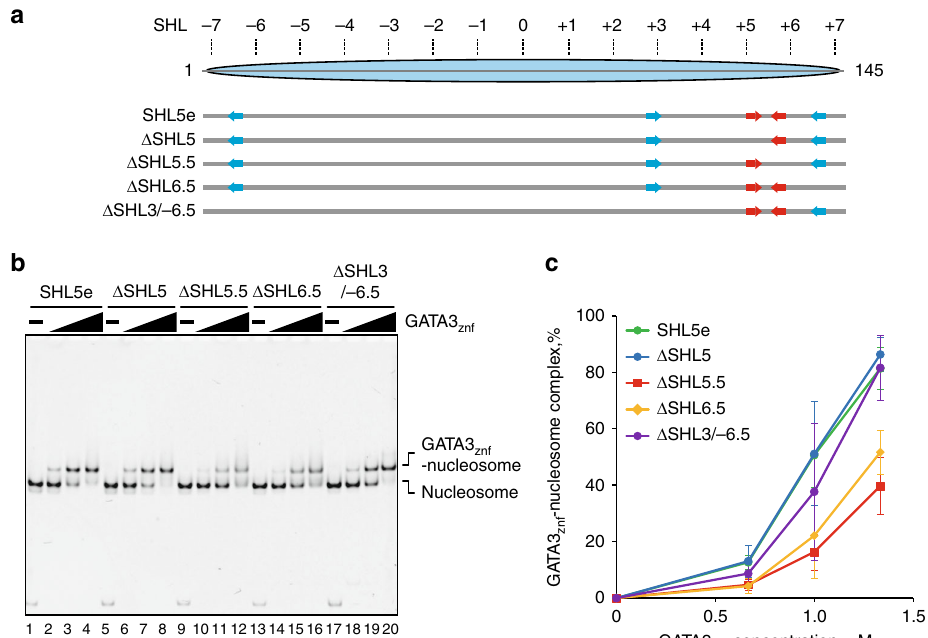
Fig. 5 GATA3 znf binds the 5 ′ -GAT-3 ′ sequences at SHL5.5 and SHL6.5. a Design of the Δ SHL5, Δ SHL5.5, Δ SHL6.5, and Δ SHL3/ − 6.5 mutants. b EMSA of the GATA3 target or mutant nucleosomes with GATA3 znf . The nucleosome (0.33 μ M) was mixed with GATA3 znf (0, 0.67, 1.0, and 1.33 μ M). The reaction mixtures were incubated at 25 °C for 30 min and were then analyzed by native-PAGE. The gel was stained with ethidium bromide. Lanes 1 – 4, 5 – 8, 9 – 12, 13 – 16, and 17 – 20 indicate results with the nucleosomes containing SHL5e, SHL5e Δ SHL5, SHL5e Δ SHL5.5, SHL5e Δ SHL6.5, and SHL5e Δ SHL3/ − 6.5, respectively. Three independent experiments were performed and the reproducibility was con fi rmed (Supplementary Fig. 7). c Quanti fi cation of the results shows in b . Data are represented as mean values± SD ( n = 3 independent biological replicates). Source data are provided as a Source Data fi le.